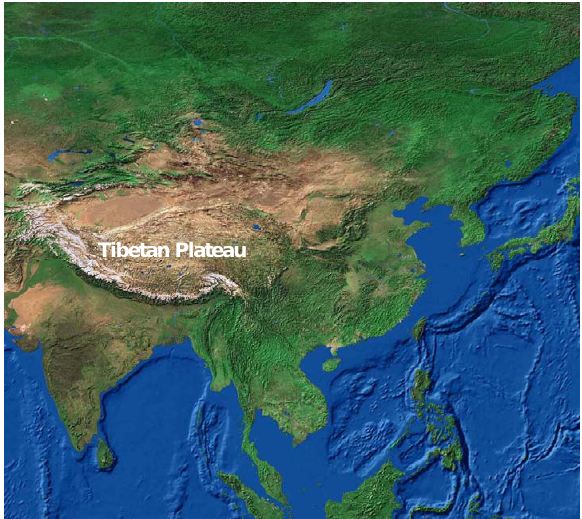
Fig. 1. The location and landscape of the Tibetan Fig.1 The location and landscape of the Tibetan Plateau.